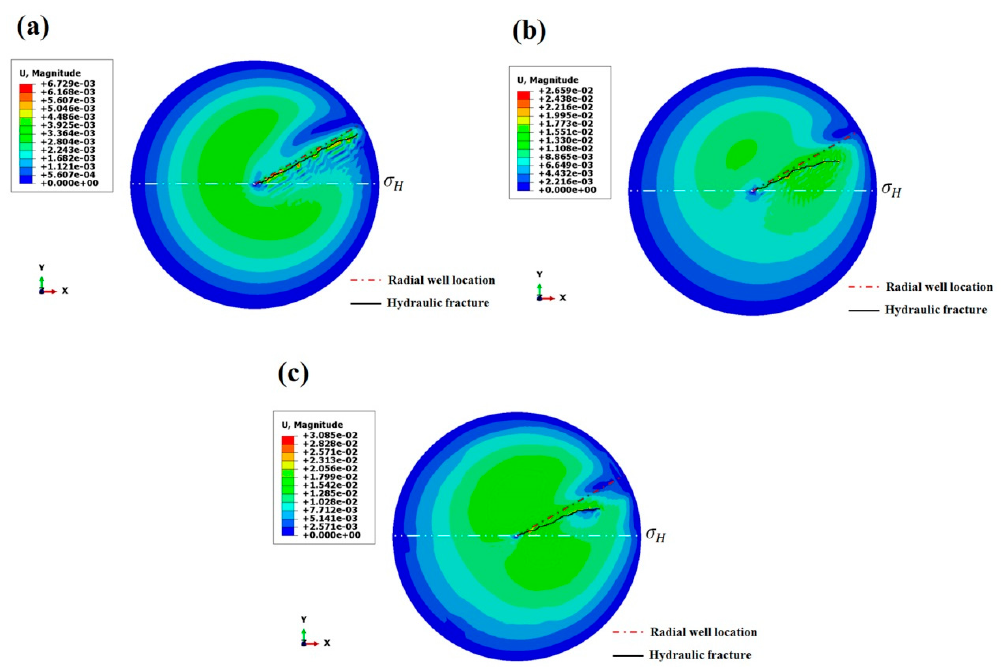
Figure 7. Simulation results of hydraulic fracture propagation guided by the single radial well under the different horizontal principal stress differences: ( a ) σ h = 39 MPa; ( b ) σ h = 36 MPa; and ( c ) σ h = 33 MPa.